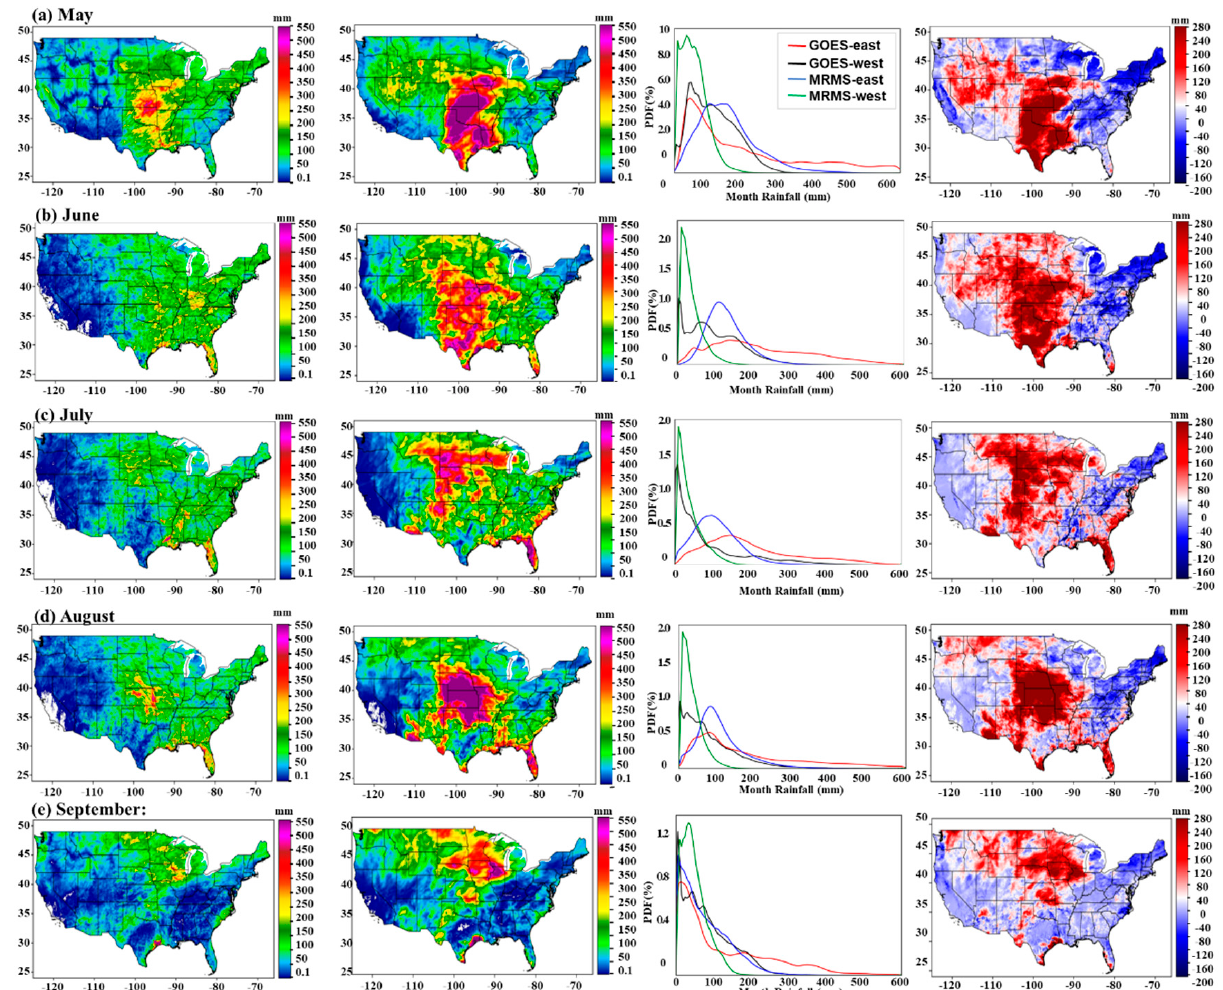
Figure 6. The comparison of monthly rainfall accumulations from the GOES-16 QPE and GC-MRMS during the warm season (May to September) in 2019. From top to bottom, the rows represent different months. From left to right, the columns are: GC-MRMS, GOES-16 QPE, PDF of monthly total rainfall, and the difference between GOES-16 QPE and GC-MRMS (the former minus the latter). Table 2. Evaluation results of monthly rainfall accumulations (CONUS-east * ).